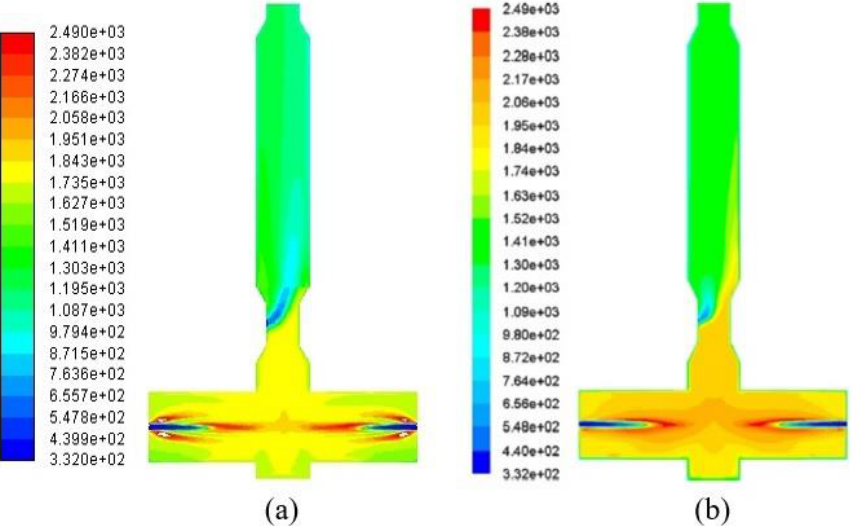
Figure 4. Comparison of temperature (K) distribution along the central plane for ( a ) the current study and ( b ) Ma et al. (2012).